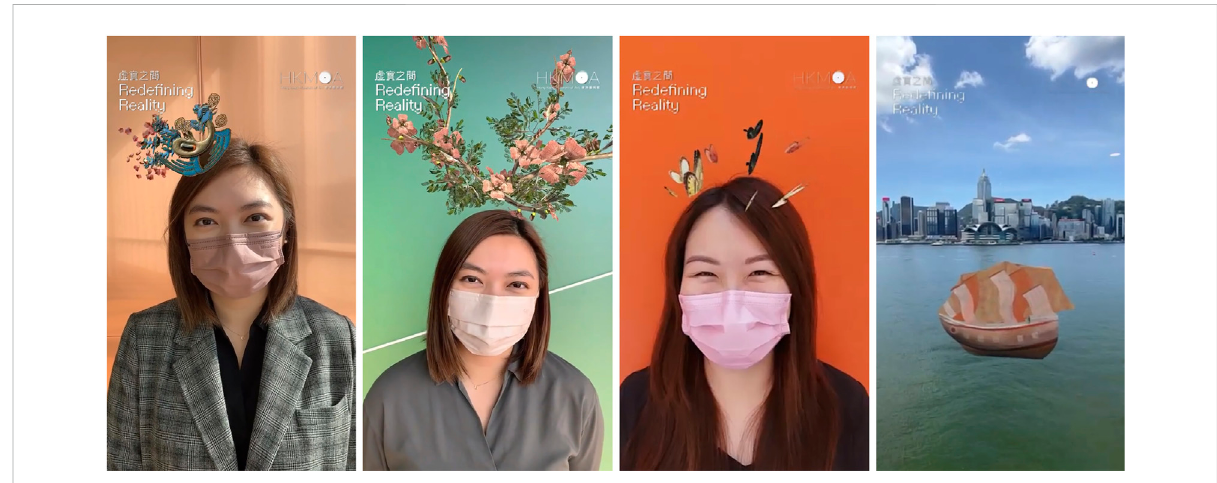
FIGURE 7 Instagram fi ltersavailableonHKMoA ’ sInstagram page.Fromlefttoright:King fi sherFeatherInlay,Qingdynasty;Birds,GuanLianchang;Insects, Guan Lianchang; Hong Kong waterfront, Kwong